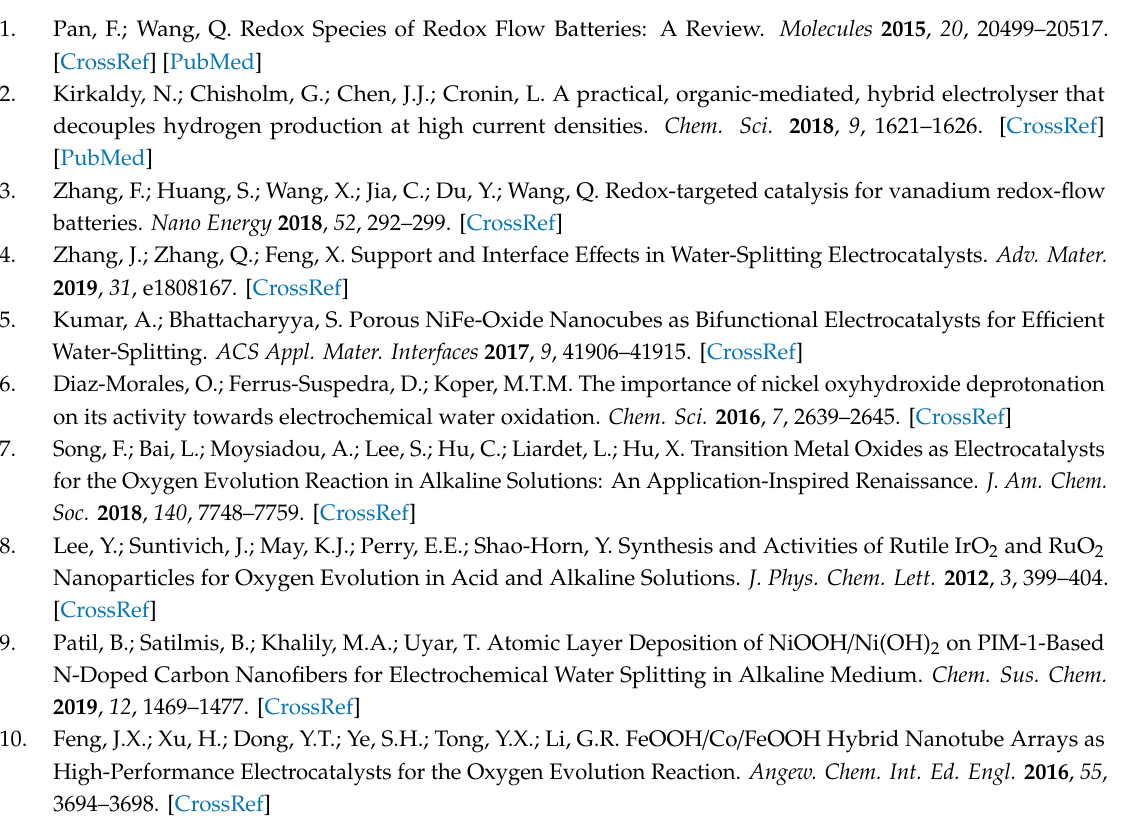
Figure S1: ( a ) SEM and ( b ) TEM images of precursor without the addition of PVP; Figure S2: ( a ) FTIR spectrum curves of the precursor and FeS 2 / C nanowires, ( b ) enlarged FTIR spectrum curves of FeS 2 / C nanowires; Figure S3: ( a ) N 2 adsorption-desorption isotherm and ( b ) pore diameter distribution of FeS 2 / C nanowires; Figure S4: CV curves of FeS 2 / C nanowires in 1 M KOH at di ff erent scan rates of 10, 50, and 100 mV / s; Figure S5: Nyquist plots of the FeS 2 / C nanowires before and after the OER test in 1.0 M KOH. Table S1: The comparison of catalytic performances for OER in 1 M KOH between the as-prepared FeS 2 / C nanowires and other materials reported in the